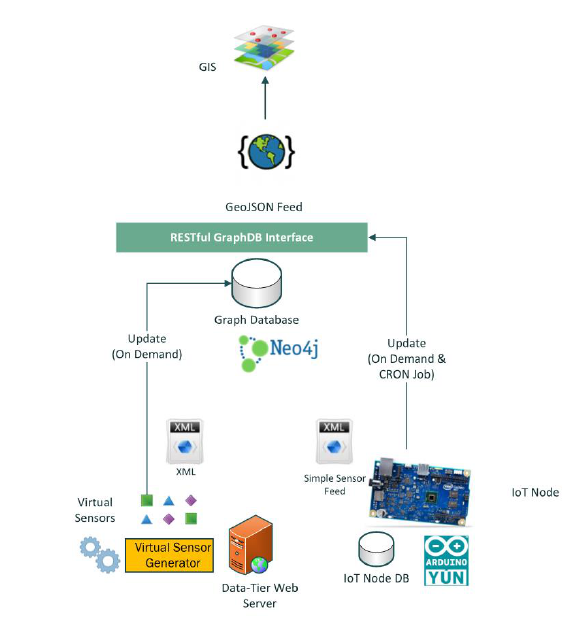
Figure 2. Integration Architecture Components